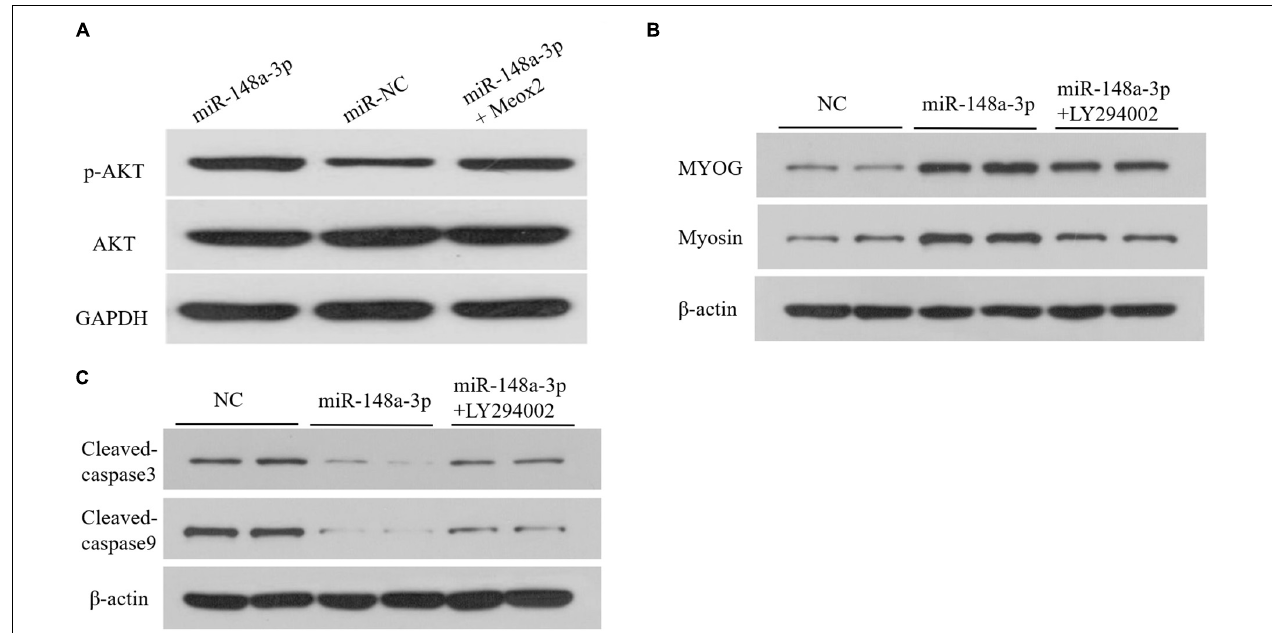
FIGURE 9 | Upregulation of miR-148a-3p suppresses the PI3K/AKT signaling pathways in SMSCs. (A) The miR-148a-3p mimic was transfected into SMSCs with pcDNA3.1 or pcDNA3.1-Meox2. At 48 h after transfection, western blot analysis was completed to assess expression of AKT, p-AKT and GAPDH. (B,C) Effect of miR-148a-3p mimics on differentiation and apoptosis of SMSCs in the absence or presence of LY294002. Data are expressed as mean ± SEM ( N = 3).